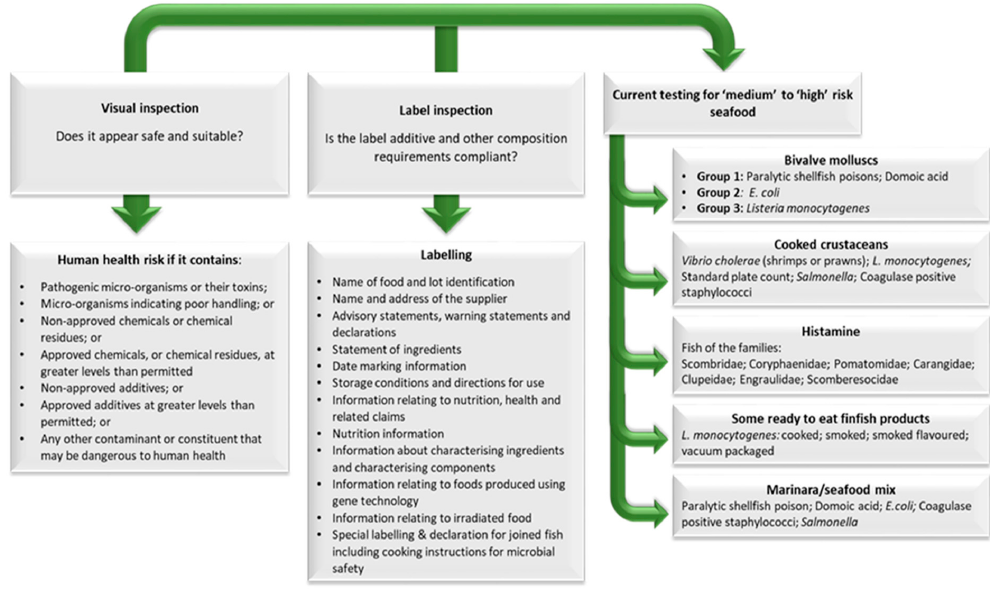
Figure 3. Representation of the legislative instruments that support the inspection of seafood imported to Australia in grey, the testing regimes for ‘surveillance’ and ‘tightened’ inspection for ‘risk foods’ in green. In yellow is the testing regime for ‘normal’, ‘reduced’, ‘compliance’ and foods which have been classified under the ‘Trans-Tasman Mutual Recognition Agreement’. ‘Compliance agreements’ are entered into voluntarily by the exporting provenance which must show compliance and equivalency with the standard of their food management systems which is audited annually. The original figure was developed from information at [18,95,96].